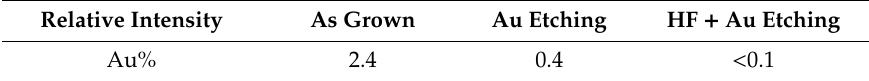
Table 1. X-ray photoelectron spectroscopy (XPS) atomic percentage of gold as revealed in the NW